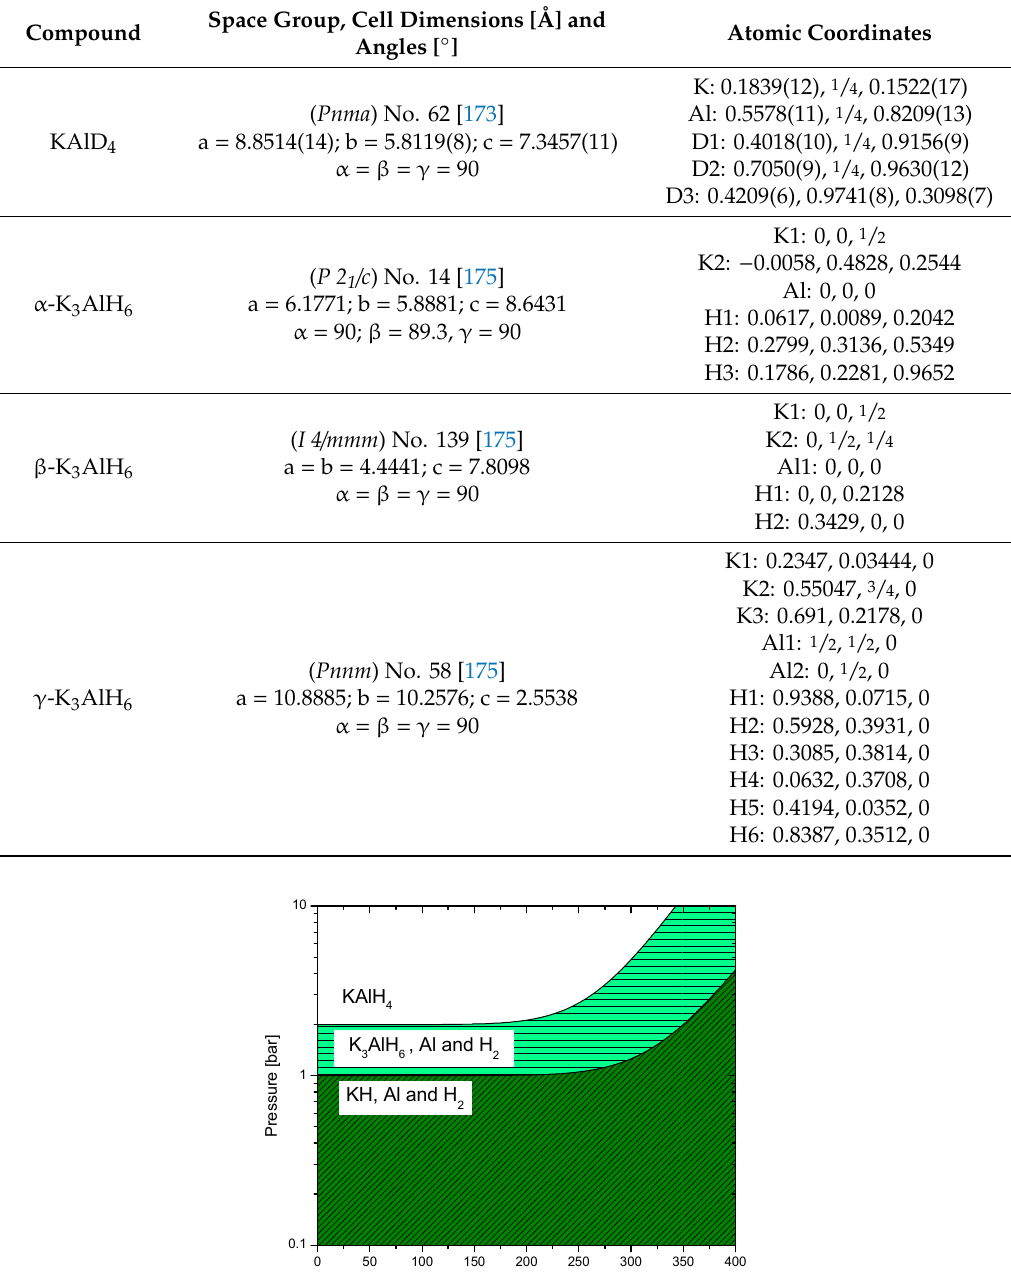
Table 4. Crystallographic data of K-alanates.